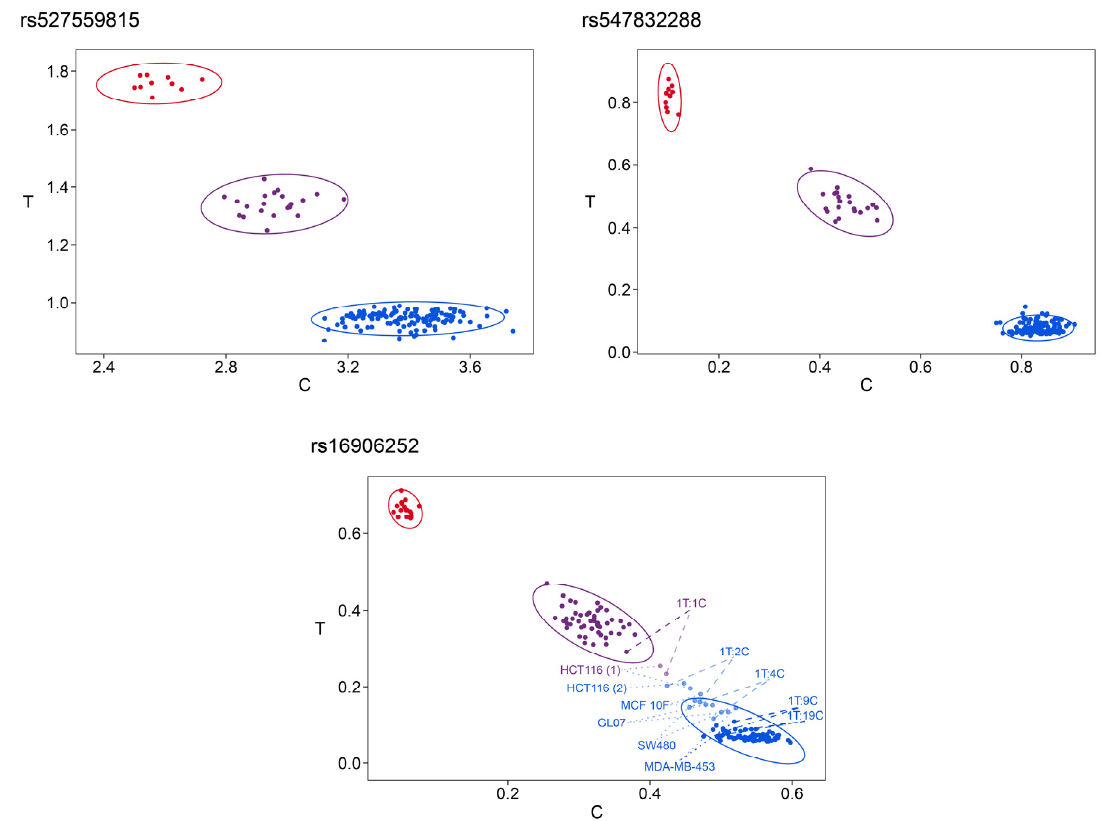
Figure 7. Cluster analysis of genotypes for each individual SNP obtained by PSQ. Peak heights of variable positions were normalized and given as ratios to the first 12 dispensations where one nucleotide was incorporated. Genotypes clustered for T/T (red), C/T (purple), and C/C (blue) for all three SNPs, respectively (95% confidence interval). When using four clusters for analyzing rs16906252, cell line samples and NHGRI sample mixtures of NA19664 (CCT/CCT) and HG01241 (CCC/CCC), which also had atypical melting curves, clustered together in a fourth cluster (shown in lighter